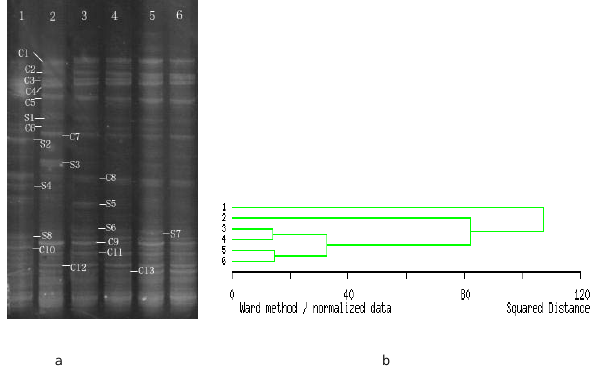
Fig. 5. DGGE analysis results from the TPH bioremediation pro- cess (a) and cluster analysis (b). Soil before remediation (1), con- trol (2), cotton (3), cotton+EMA (4), cotton+PGPR (5), and cot- ton+PGPR+EMA (6).